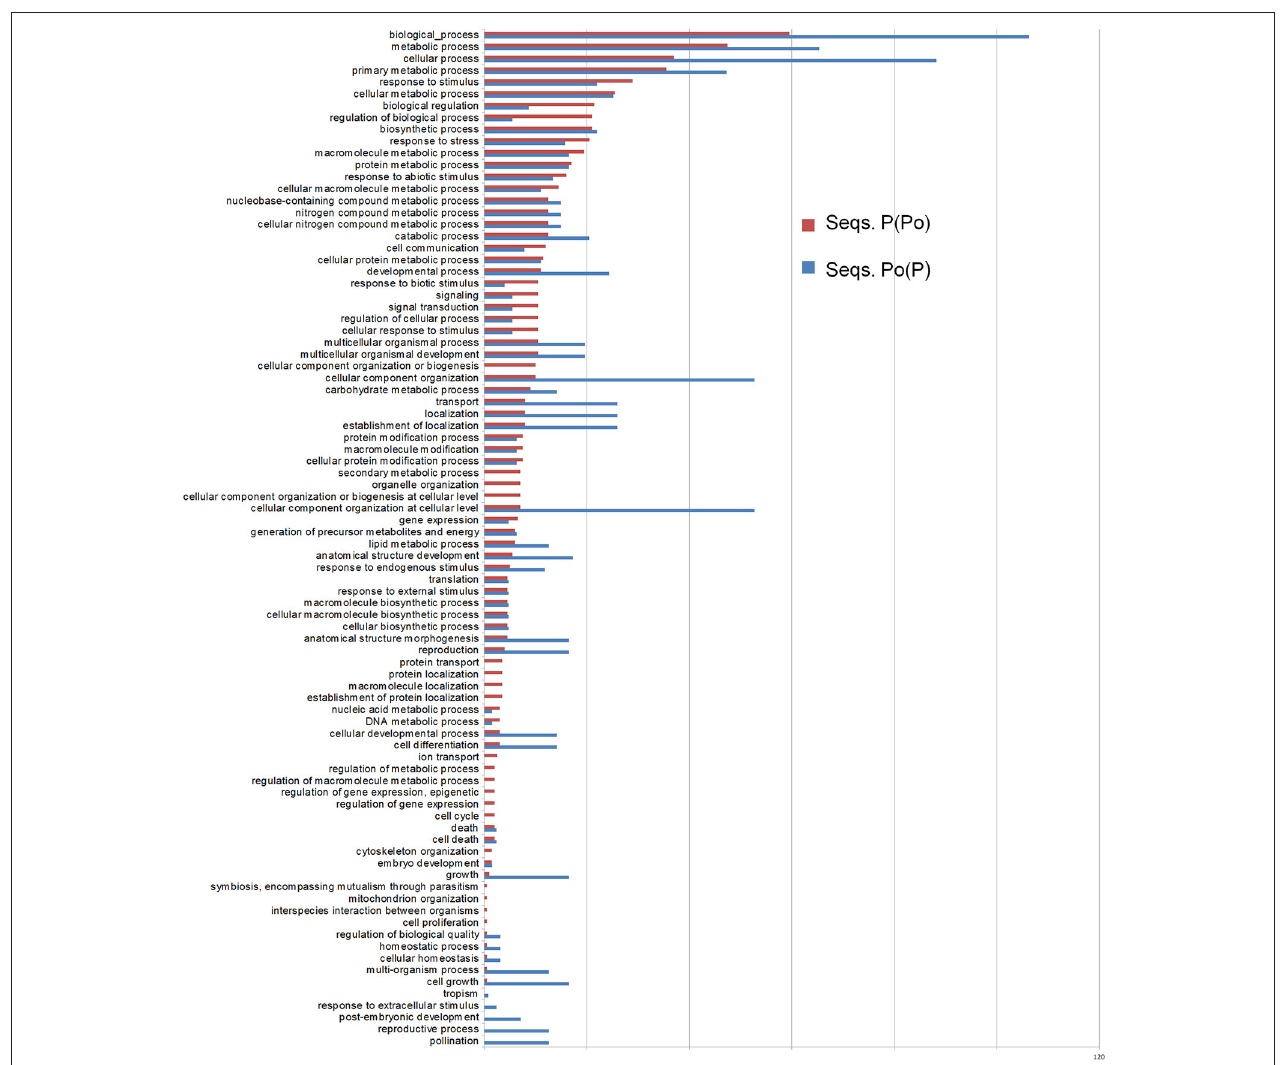
FIGURE 6 | Differential Gene Ontology terms between the Po(P) and P(Po) libraries. The distribution of GO terms has been created as relative percentage considering the number of total ESTs obtained for each library.